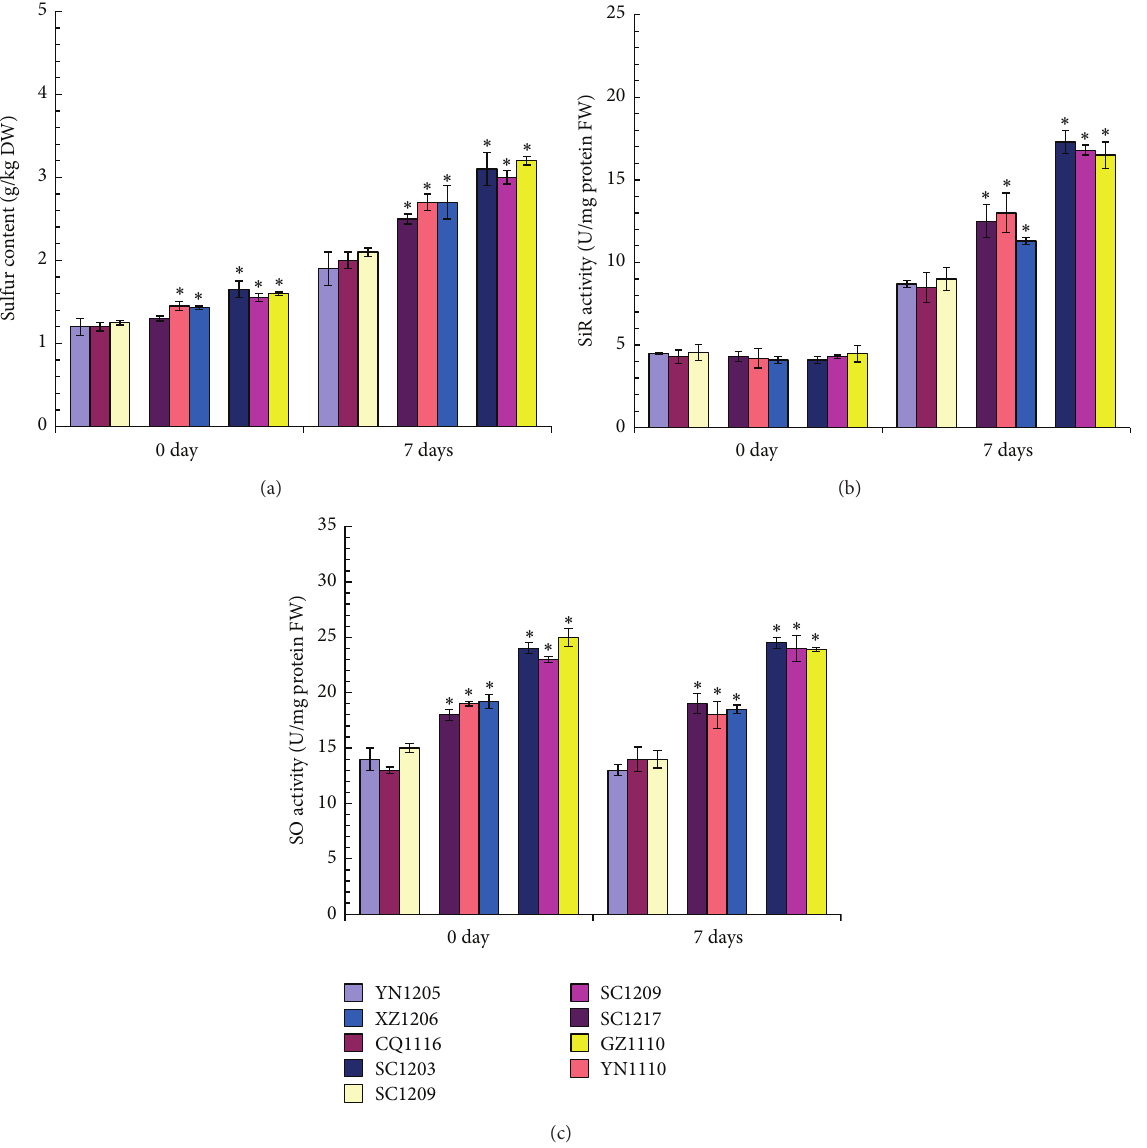
Figure 7: Comparison of sulfur contents (a), SiR activities (b), and SO activities (c) in leaves from nine selected C. dactylon accessions in response to SO 2 stress. Mean values are presented with vertical error bars representing the standard deviations ( 𝑛 = 3 ). The asterisk symbols indicate significant differences between SO 2 -sensitive accessions and SO 2 -tolerant